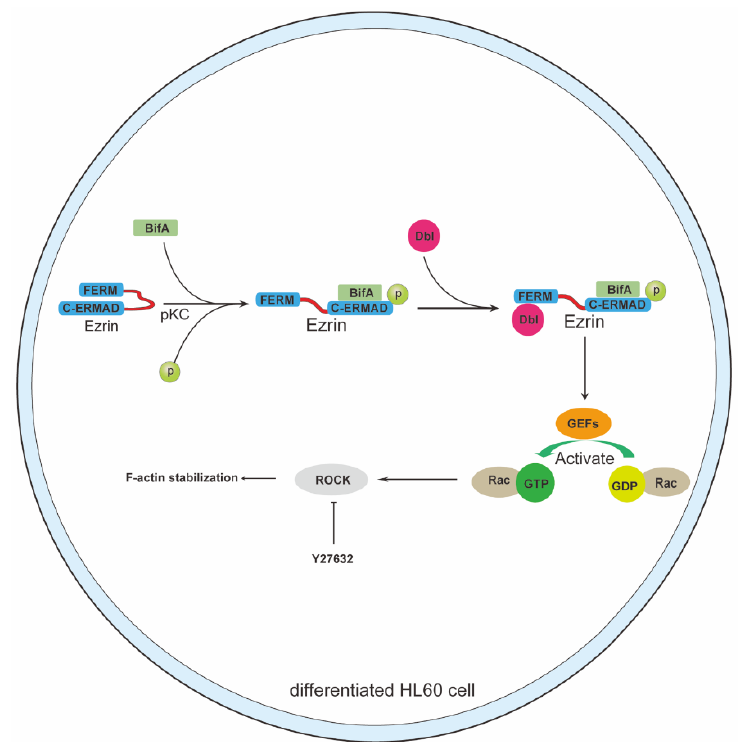
Figure 5. Schematic model of molecular mechanism of BifA decreases neutrophils killing capability to SEZ. BifA increases and keeps the ezrin aberrant phosphorylation level in a PKC-dependent manner. The p-ezrin recruits Dbl (guanine nucleotide-exchange factor) and promotes inactive GDP- bound Rac1 to transfer to active GTP-bound Rac1. The extraordinary activation of Rac1 may lead to phagocytosis dysfunction and impair other actin-dependent processes of dHL60 cells. The appropriate concentration of ROCK inhibitor Y27632 restores neutrophils function by maintaining Rho-ROCK pathway stability.